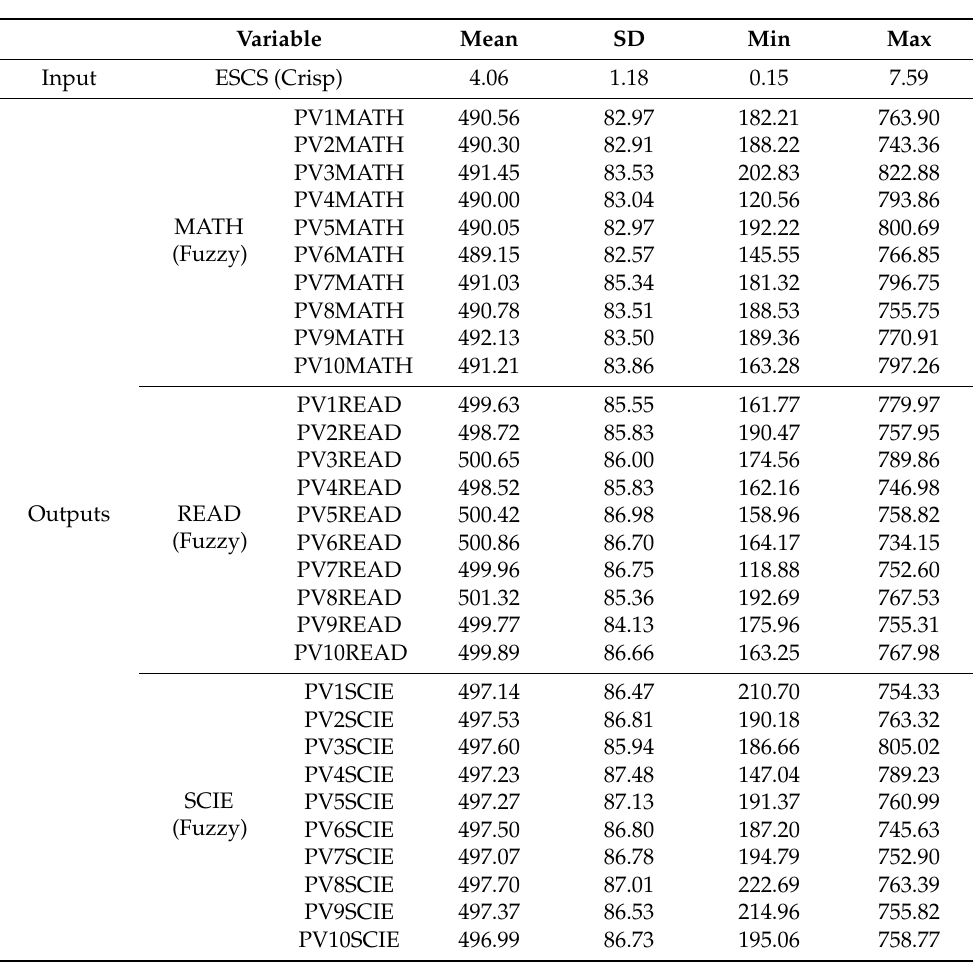
Table 3. Descriptive